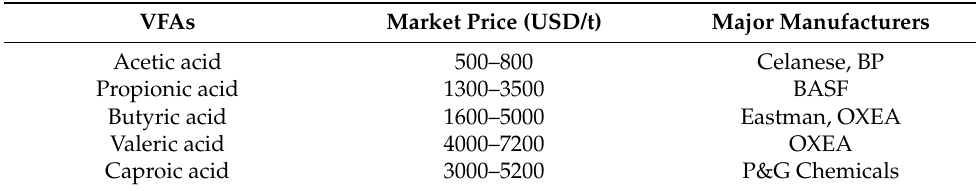
Table 4. Market price of VFAs [129].